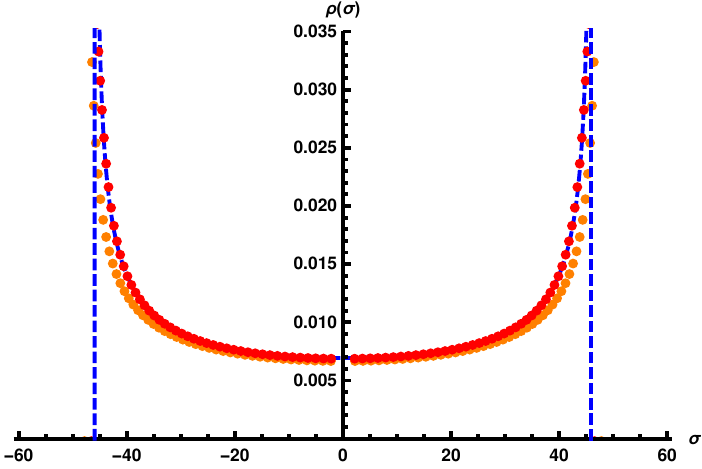
Figure 8 . The eigenvalue distribution of 6 d MSYM for N = 100 and (cid:21) QFT = (cid:0) 20. In particular the orange dots correspond to the numerical solution of (2.6) at (cid:21) b = 0 : 42 and d = 5 : 995 ( (cid:15) = 0 : 005). The latter parameters correspond to (cid:21) QFT = (cid:0) 20 according to (4.48). The red dots in turn correspond to the numerical solution of (C.1) at N = 100 and (cid:21) QFT = (cid:0) 20. Finally the dashed blue line shows the eigenvalue density (C.4) with the endpoint position b given by